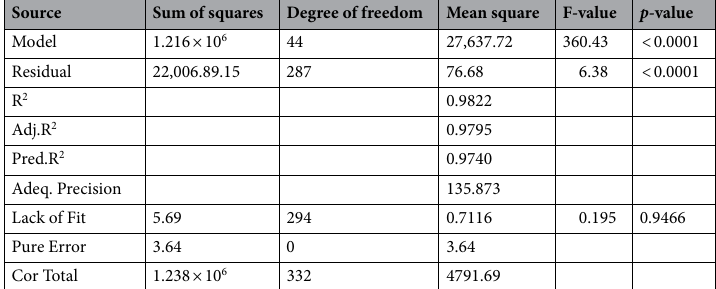
Table 3. ANOVA for response surface quadratic